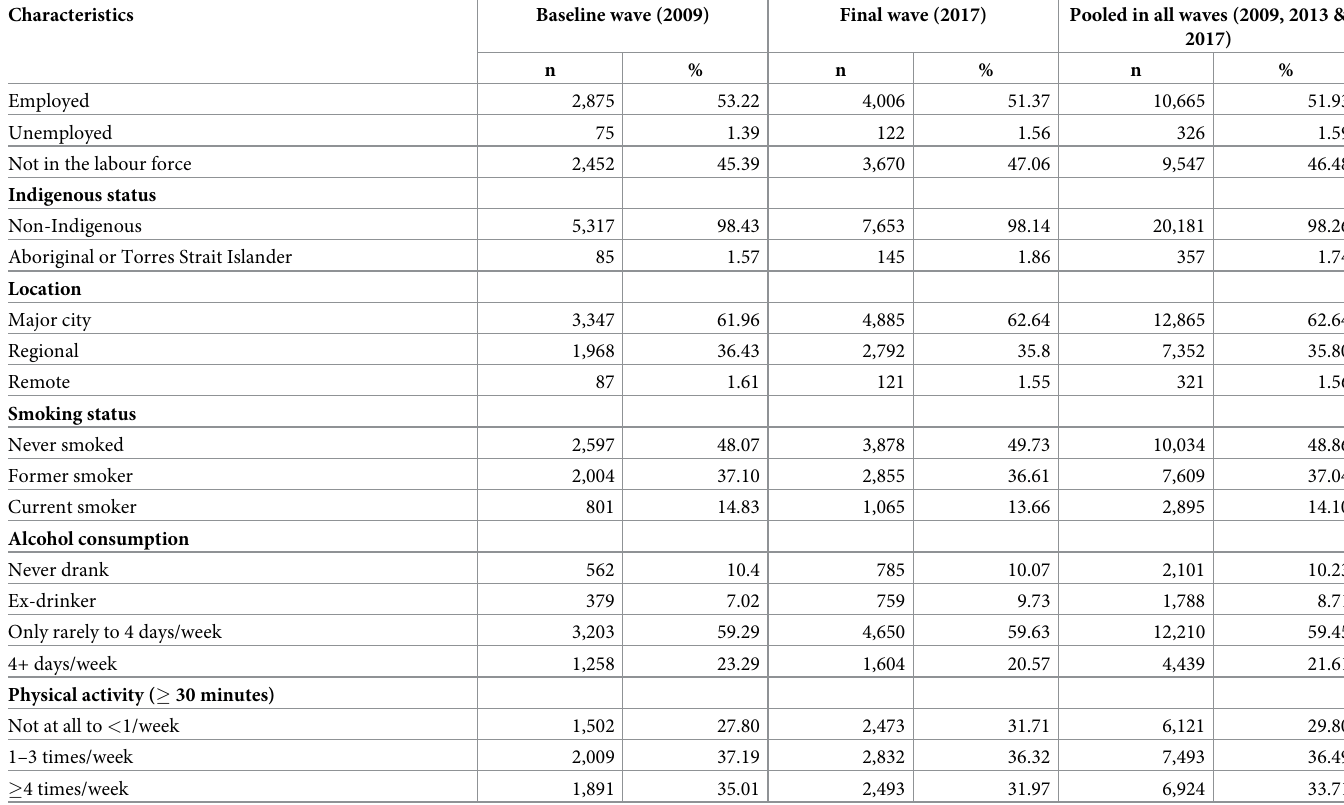
PLOS ONE | https://doi.org/10.1371/journal.pone.0260158 November16,